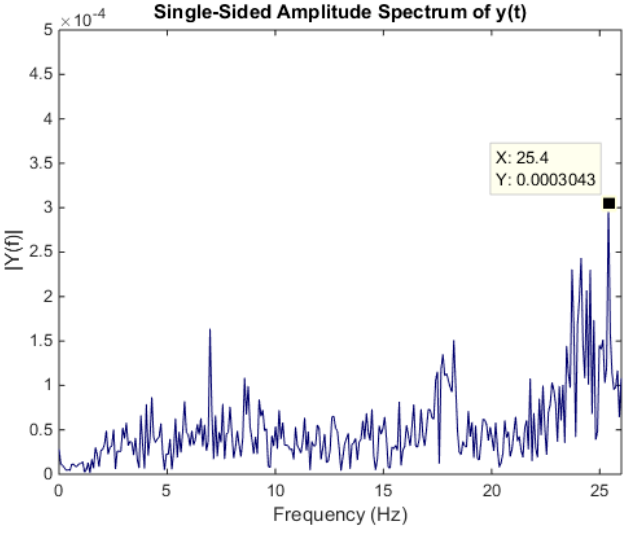
Figure 6. FFT plot of machining signal. Table 2. Background machine distance measures .